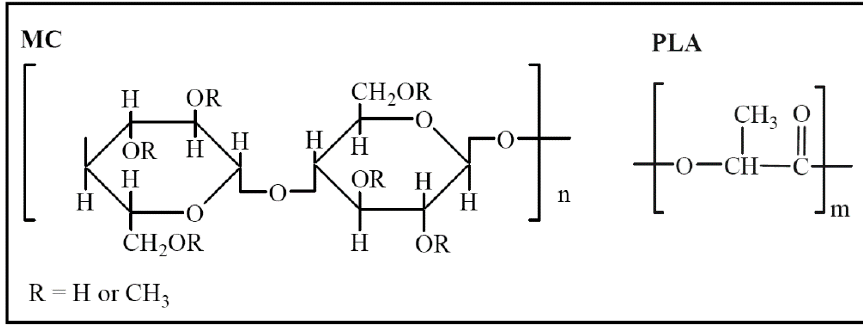
Figure 1. Chemical structures of methylcellulose (MC) and polylactic acid (PLA).